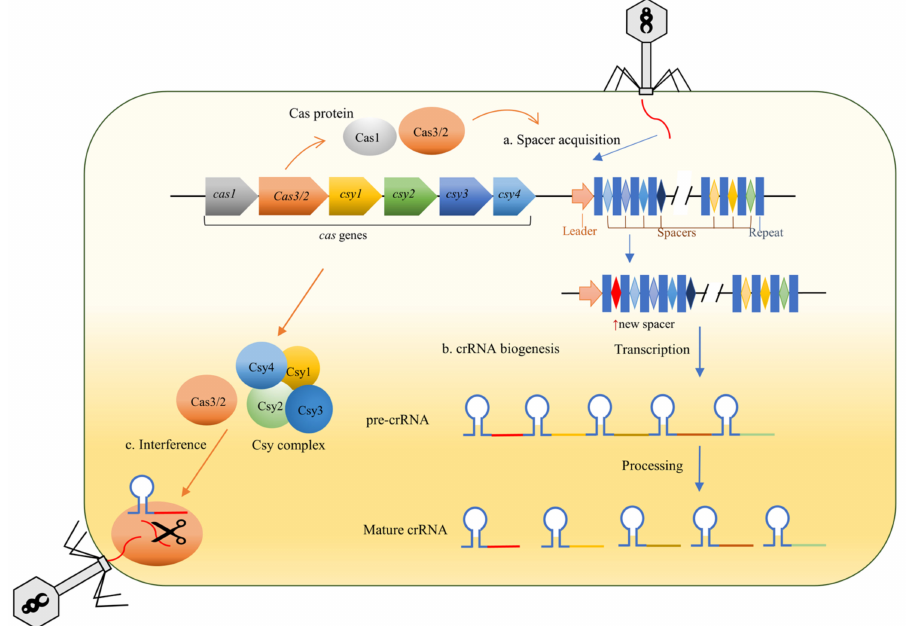
Figure 1. Schematic of how CRISPR-Cas system provides immunity. The immune function of type I-F CRISPR-Cas system can be roughly divided into three stages: adaptation (spacer acquisition), crRNA biogenesis, and target interference. When foreign genetic elements such as bacteriophage invade host bacteria, the relevant Cas proteins (Cas1 and Cas3/2) select small DNA fragments from foreign genetic elements and integrate them into the CRISPR array as the new spacer. The crRNA biogenesis begins with the transcription of CRISPR array into the pre-crRNA, which is then processed by specific nucleases into mature crRNA. In this process, Cas protein also begins to be expressed, allowing the recognition and binding of crRNA. In the final stage, if the phage invades again, the crRNA can be complementarily paired with the protospacer of the foreign nucleic acid, which guides the Cas3/2 nuclease-helicase to cut the target nucleic acid at a specific position, thereby resisting the invasion of the foreign genetic